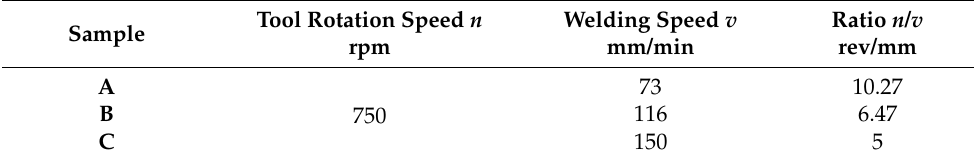
Table 3. Friction stir welding